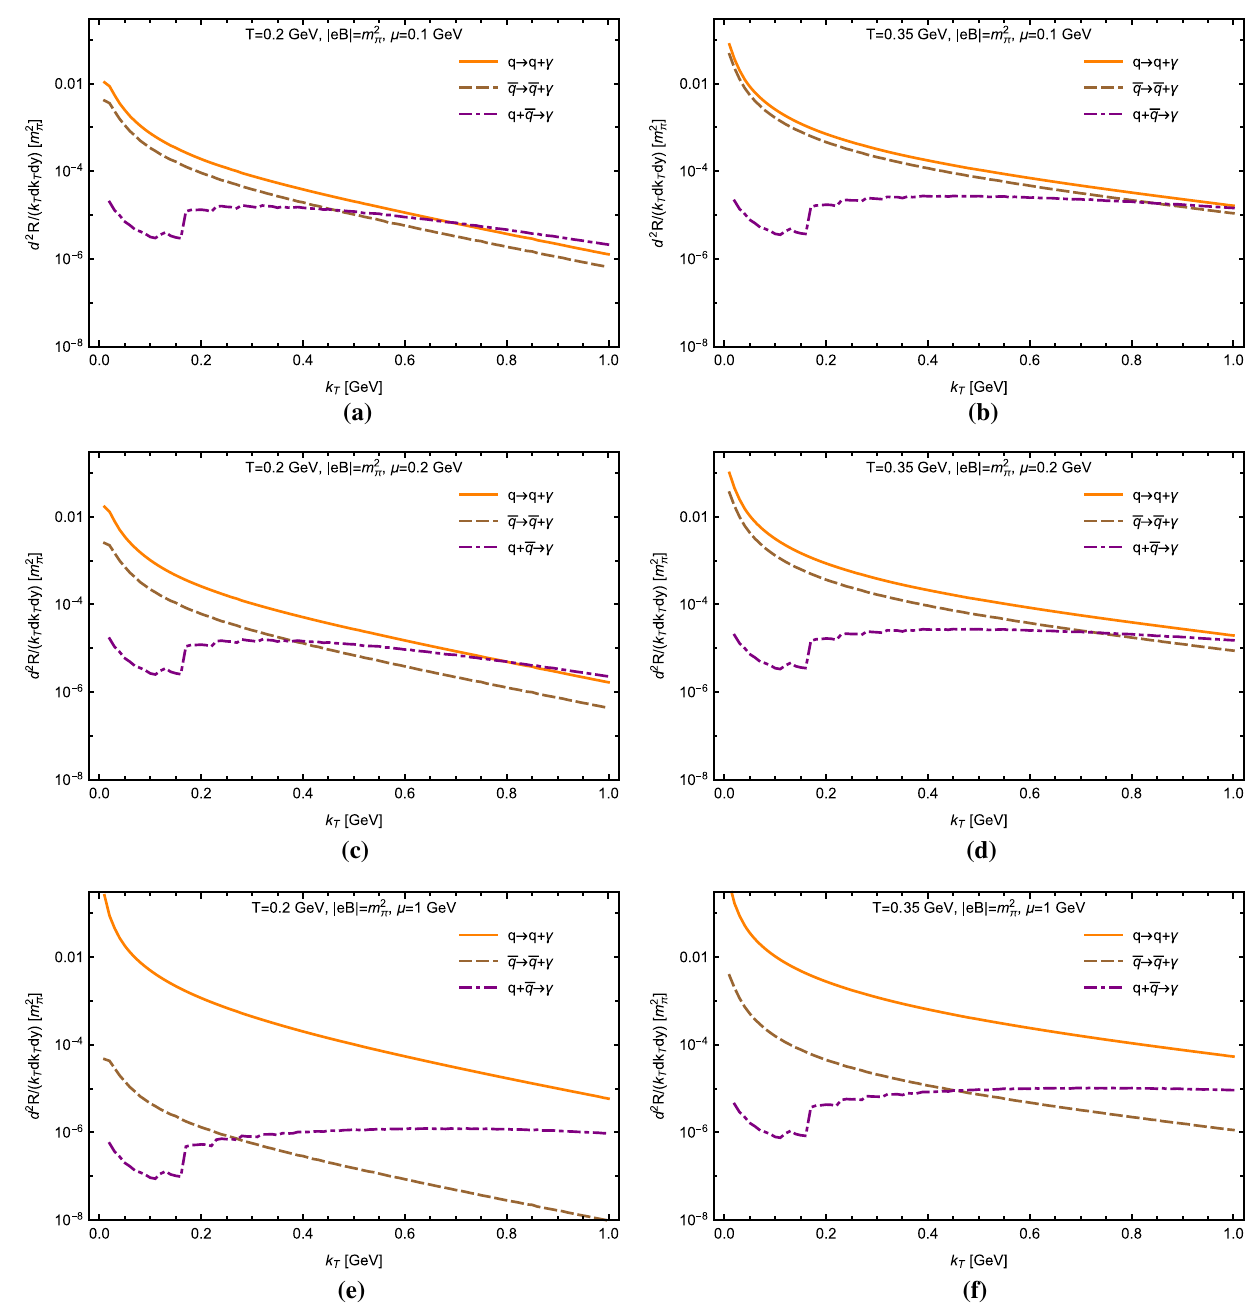
Fig. 2 Partial contributions of different types of processes, i.e., q → q + γ (orange lines), ¯ q → ¯ q + γ (brown dashed lines), and q + ¯ q → γ (purple dot-dashed lines), to the photon production rate at | eB | = m 2 π as a function of the transverse momentum k T . The left panels ( a , c ,